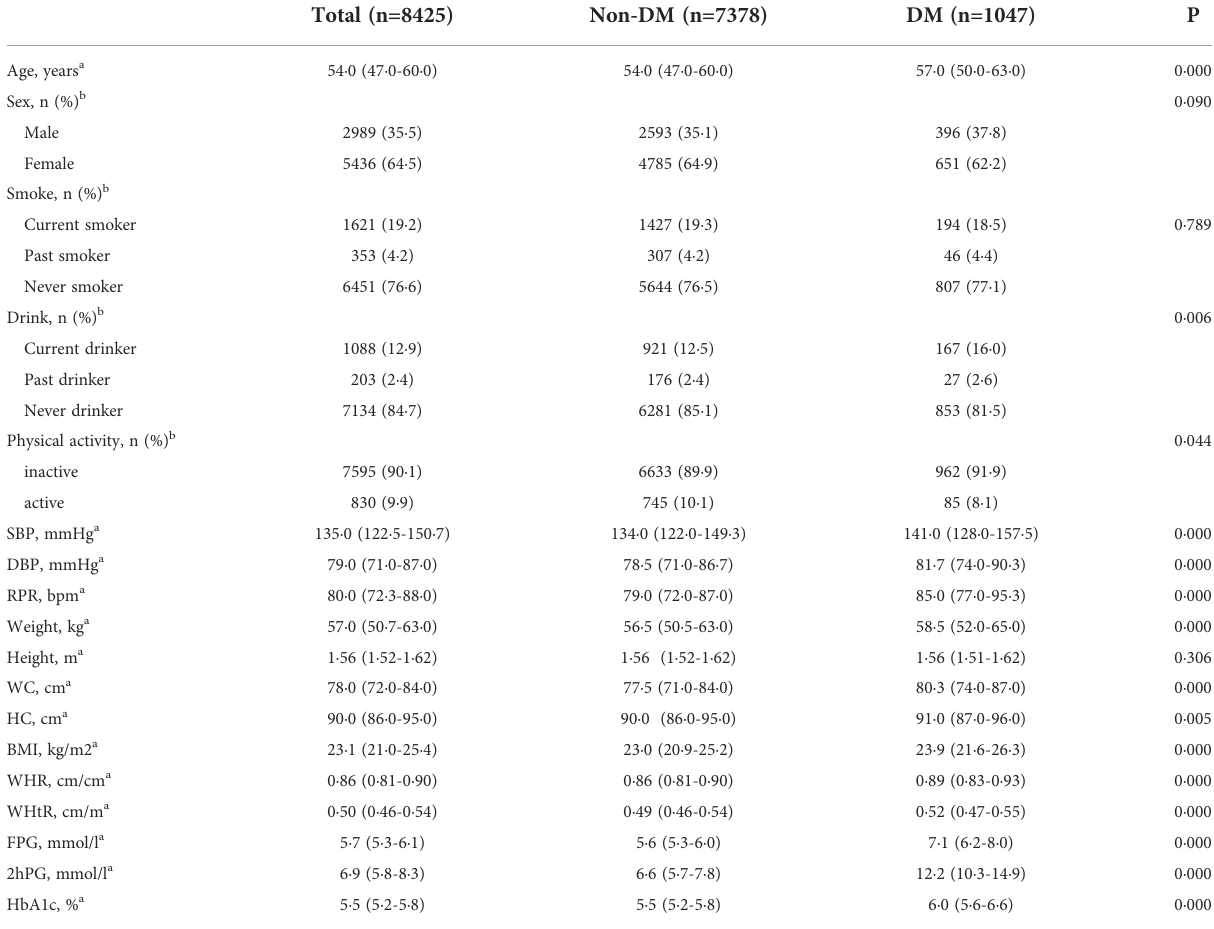
TABLE 1 Characteristics of